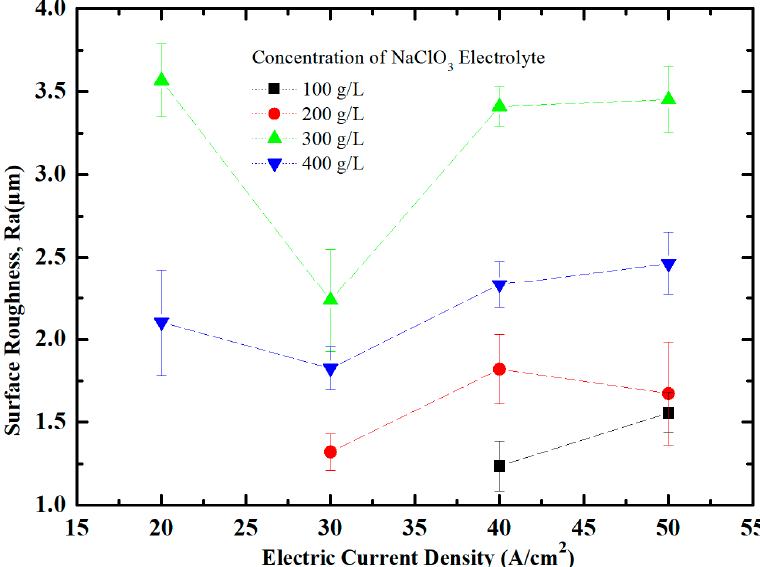
Figure 11. Surface roughness of workpiece at different current density.